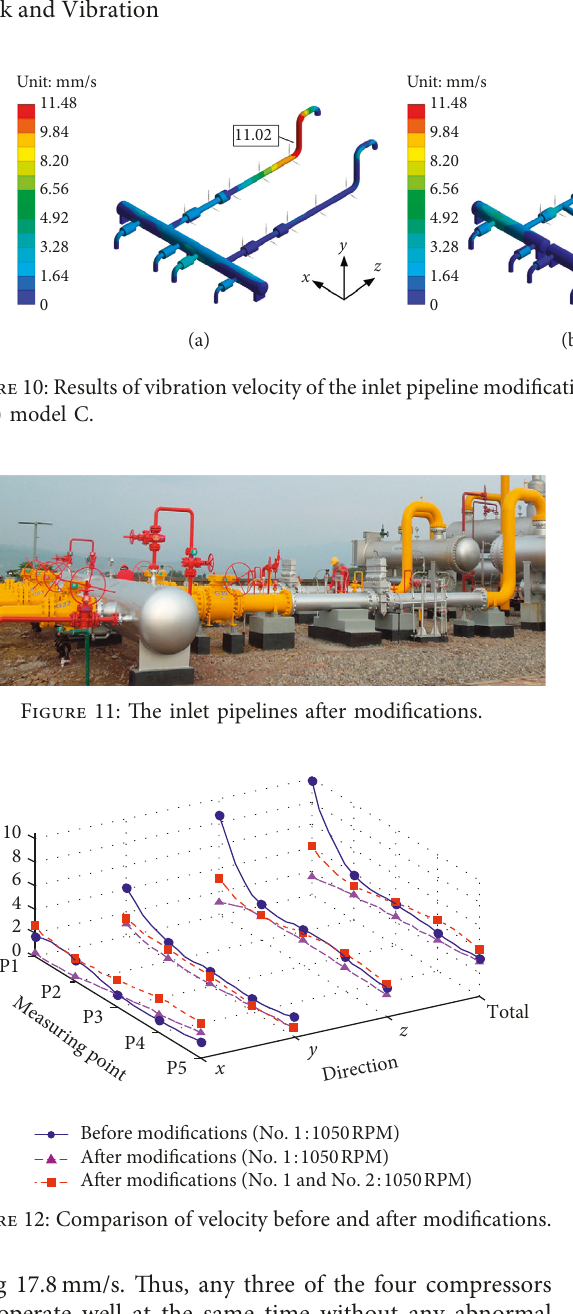
Figure 13: The results of pressure pulsation of ② after modifi- cations. (a) Pressure-time curve; (b) frequency